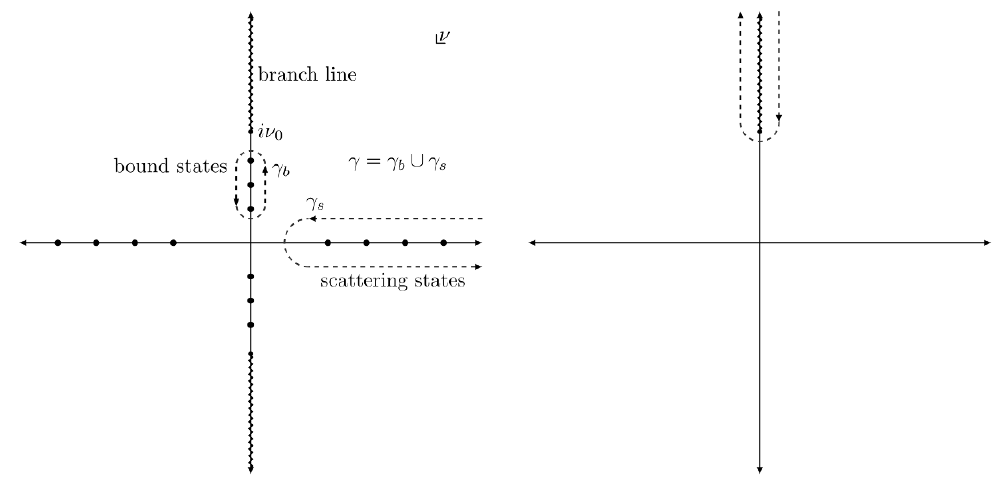
Figure 1 . Left: contour in the complex (cid:23) -plane for the integral (4.5). Right: after deforming the contour, the integral is performed over the branch cut at the positive imaginary